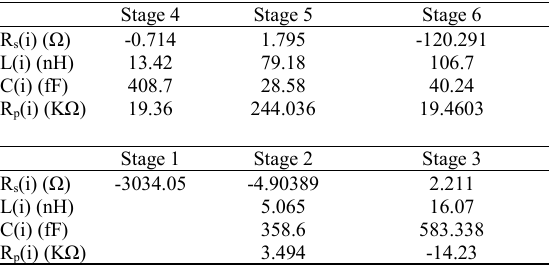
Table 1: RLC parameters for the spice circuit without CRR.